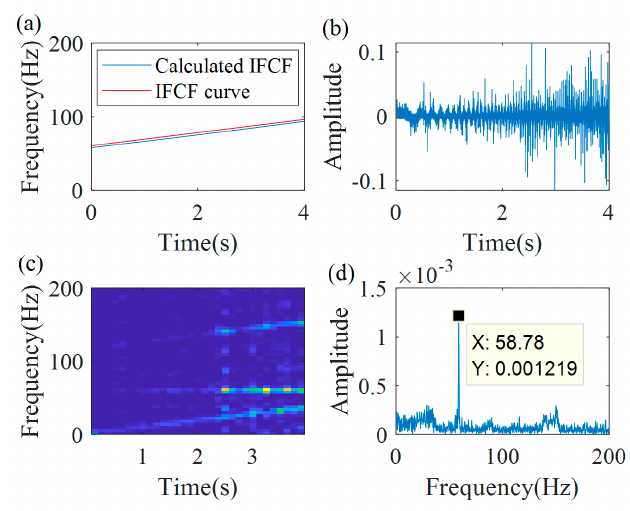
Figure 20. Multiple demodulation results: ( a ) calculated instantaneous fault characteristic frequency (IFCF) curve; ( b ) demodulation signal; ( c ) TFR; and ( d ) the spectrum.